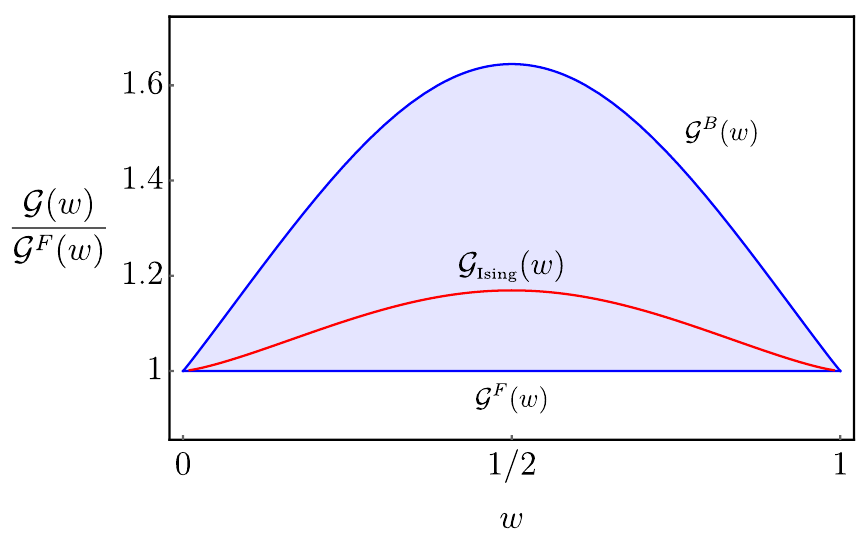
Figure 1 . Upper and lower bounds on CFT correlators G ( w ) := G ( w, w ) of a field of dimension ∆ φ , shown for the case ∆ φ = ∆ Ising ∼ 0 . 518 . Here G B,F stand for the Bosonic/Fermionic generalized σ free field correlators, G B,F ( w ) = ± 1 + w − 2∆ φ + (1 − w ) − 2∆ φ . Any unitary CFT correlator must live inside the shaded region, with the caveat that the upper bound is only valid for correlators where the first operator has scaling dimension ∆ g ≥ 2∆ φ . In red the 3d Ising spin field correlator computed from the CFT data provided in